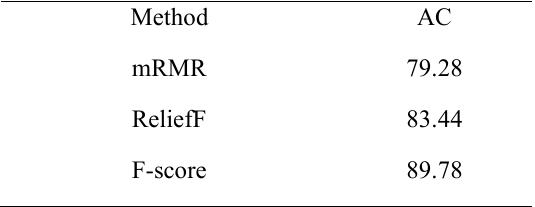
Table 5. Comparison results with other